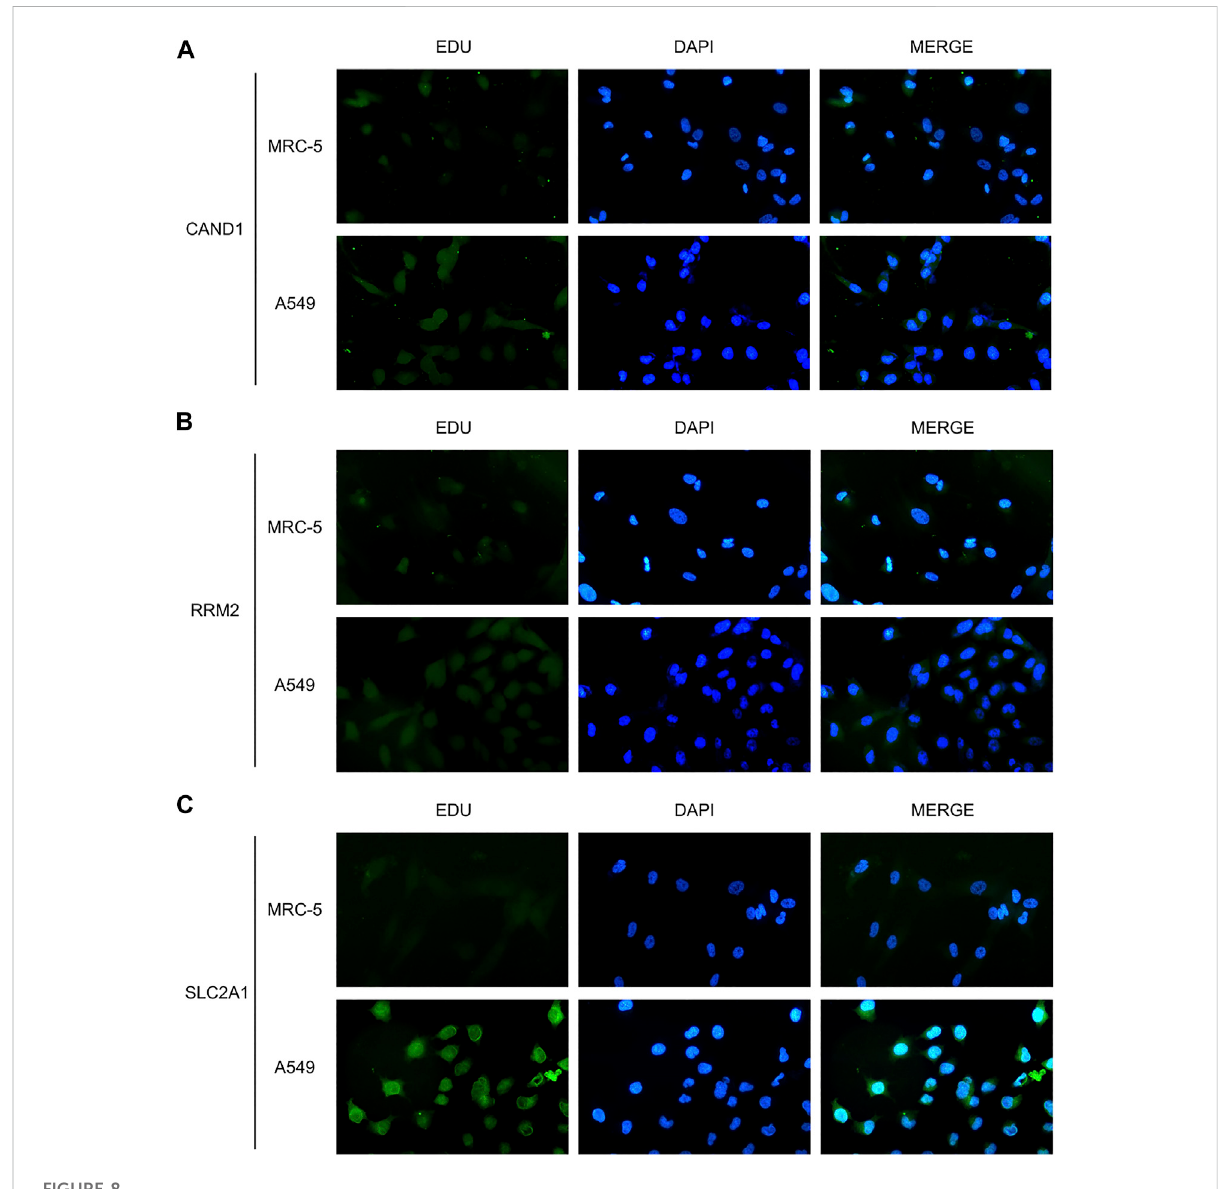
FIGURE 8 Immuno fl uorescence staining. (A) CAND1. (B) RRM2. (C)